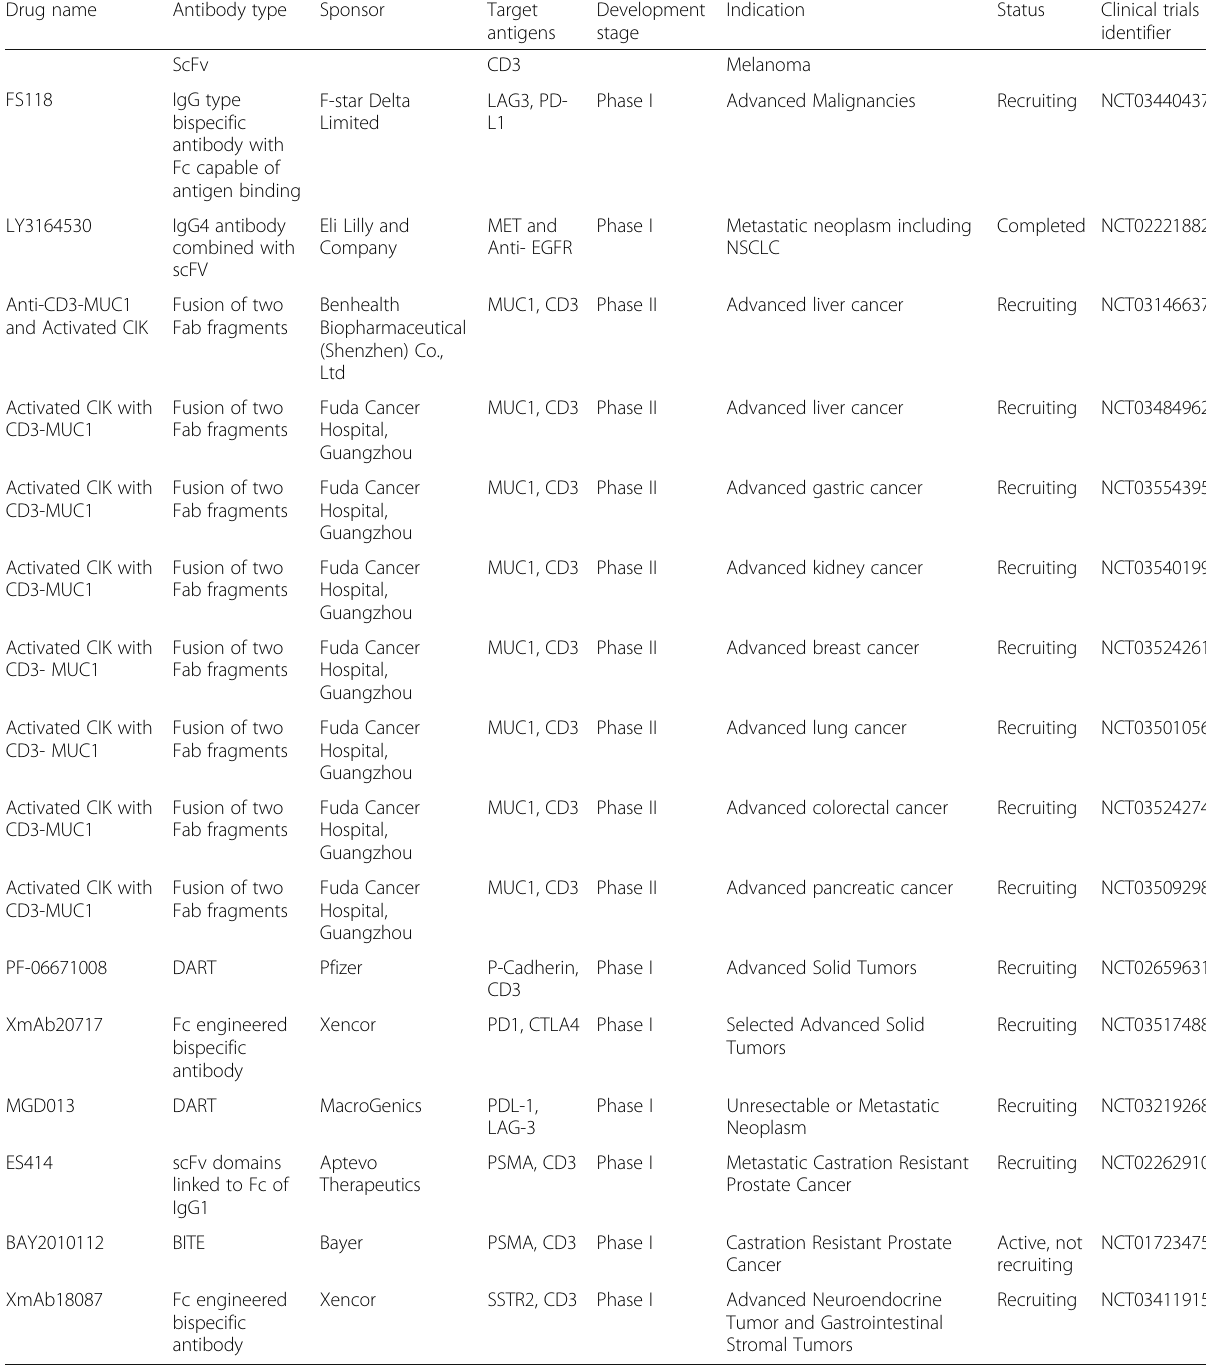
Table 4 Recent clinical trials involving the use of bispecific antibodies in solid tumor malignancies